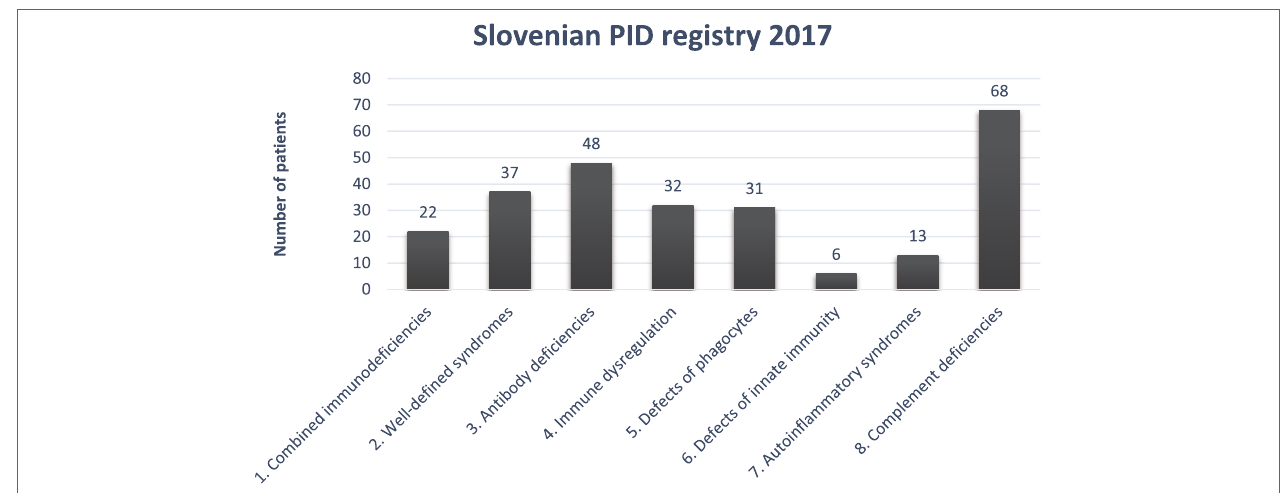
FigUre 1 | Distribution of primary immunodeficiencies (PIDs) in the Slovenian PID registry. Combined immunodeficiencies: severe combined immunodeficiency, combined immunodeficiency; well-defined syndromes: DiGeorge, ataxia-telangiectasia, hyper IgE. Wiskott-Aldrich, Nijmegen, Netherton, Schimke, osteopetrosis; antibody deficiencies: x-linked agammaglobulinemia, common variable immunodeficiency. IgA deficiency, class switch defect; immune dysregulation: autoimmune lymphoproliferative syndrome; candidiasis, ectodermal dysplasia; x-linked lymphoproliferative syndrome, familial hemophagocytic lymphohistiocytosis autoimmune lymphoproliferative syndrome, MALT1 deficiency, Chediak-Higashi, AEP2/3 deficiency; phagocytic defects: chronic granulomatous deficiency, congenital neutropenia, Papillon-Lefevre, Schwachman-Diamond, Barth; defects of innate immunity: NEMO deficiency; autoinflammatory syndromes: chronic recurrent multifocal osteomyelitis, cryopyrin-associated periodic syndrome, TNF-alpha receptor-associated periodic syndrome; complement deficiencies: C1–C9 deficiencies, hereditary angioedema, properdin